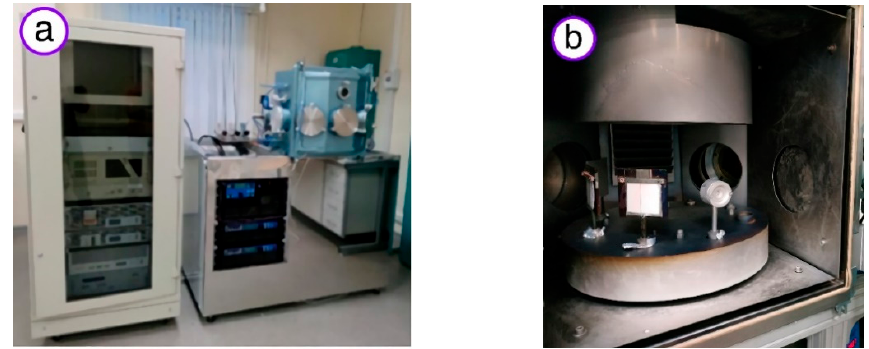
Figure 1. Photos of magnetron installation ( a ) and its vacuum chamber with loaded samples ( b ).